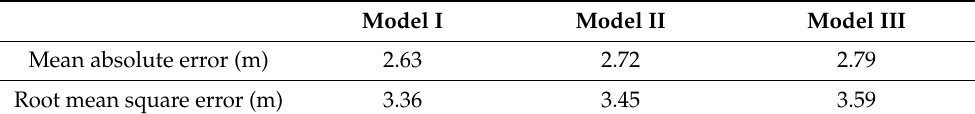
Table 1. Presentation of model results.